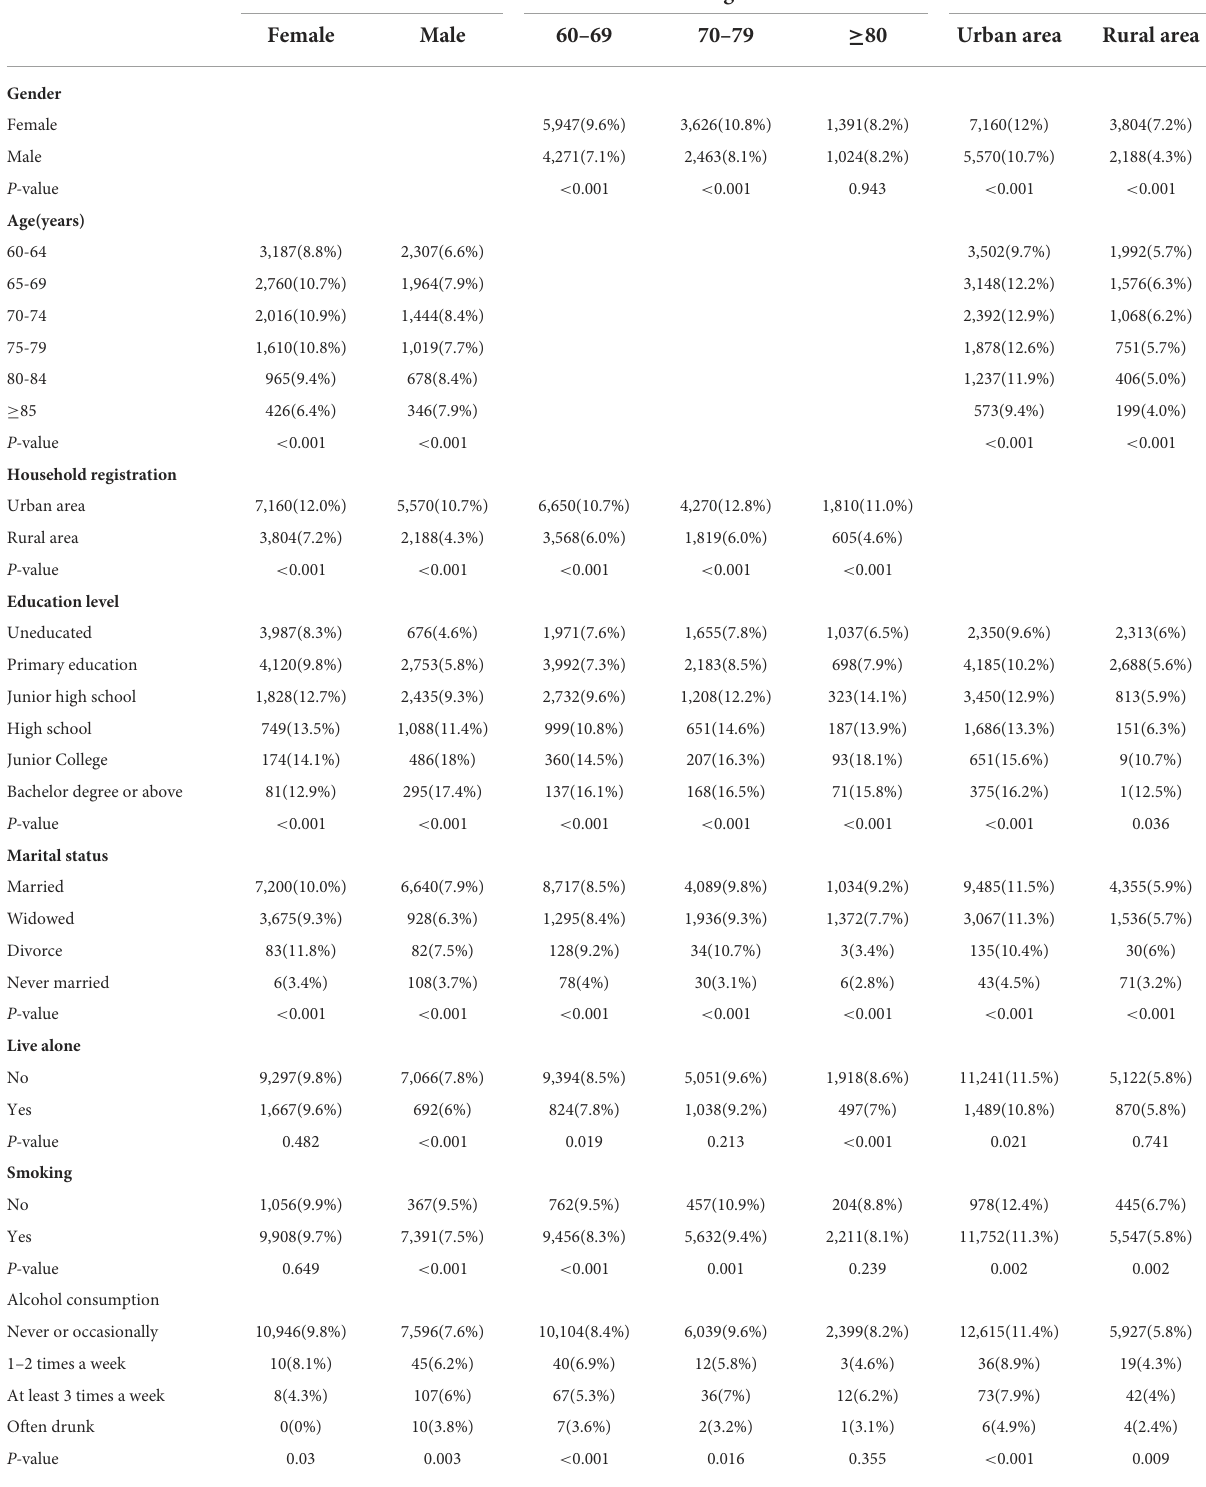
TABLE 4 The prevalence of diabetes by gender/urban and rural/age